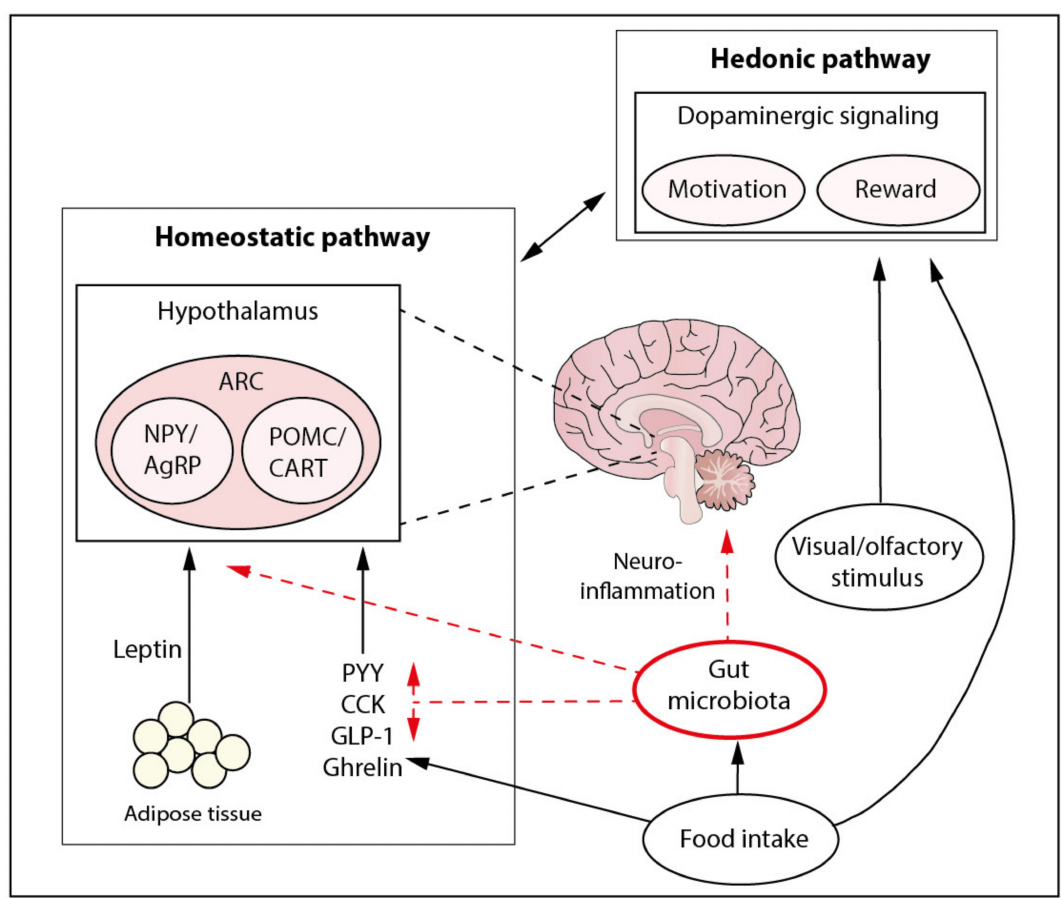
Figure 2. Possible mechanisms through which the gut microbiota could affect the homeostatic and hedonic pathways. The homeostatic pathway includes the processing of signals from white adipose tissue-derived leptin and